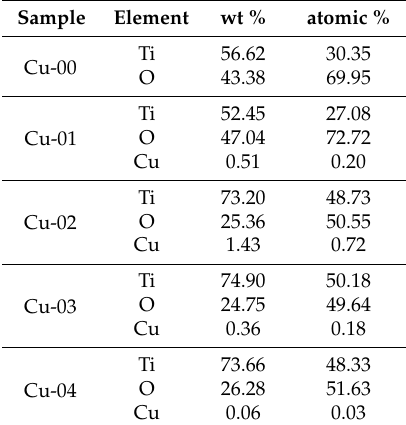
Table 3. Energy dispersive X-ray spectroscopy (EDX) analysis of all samples.